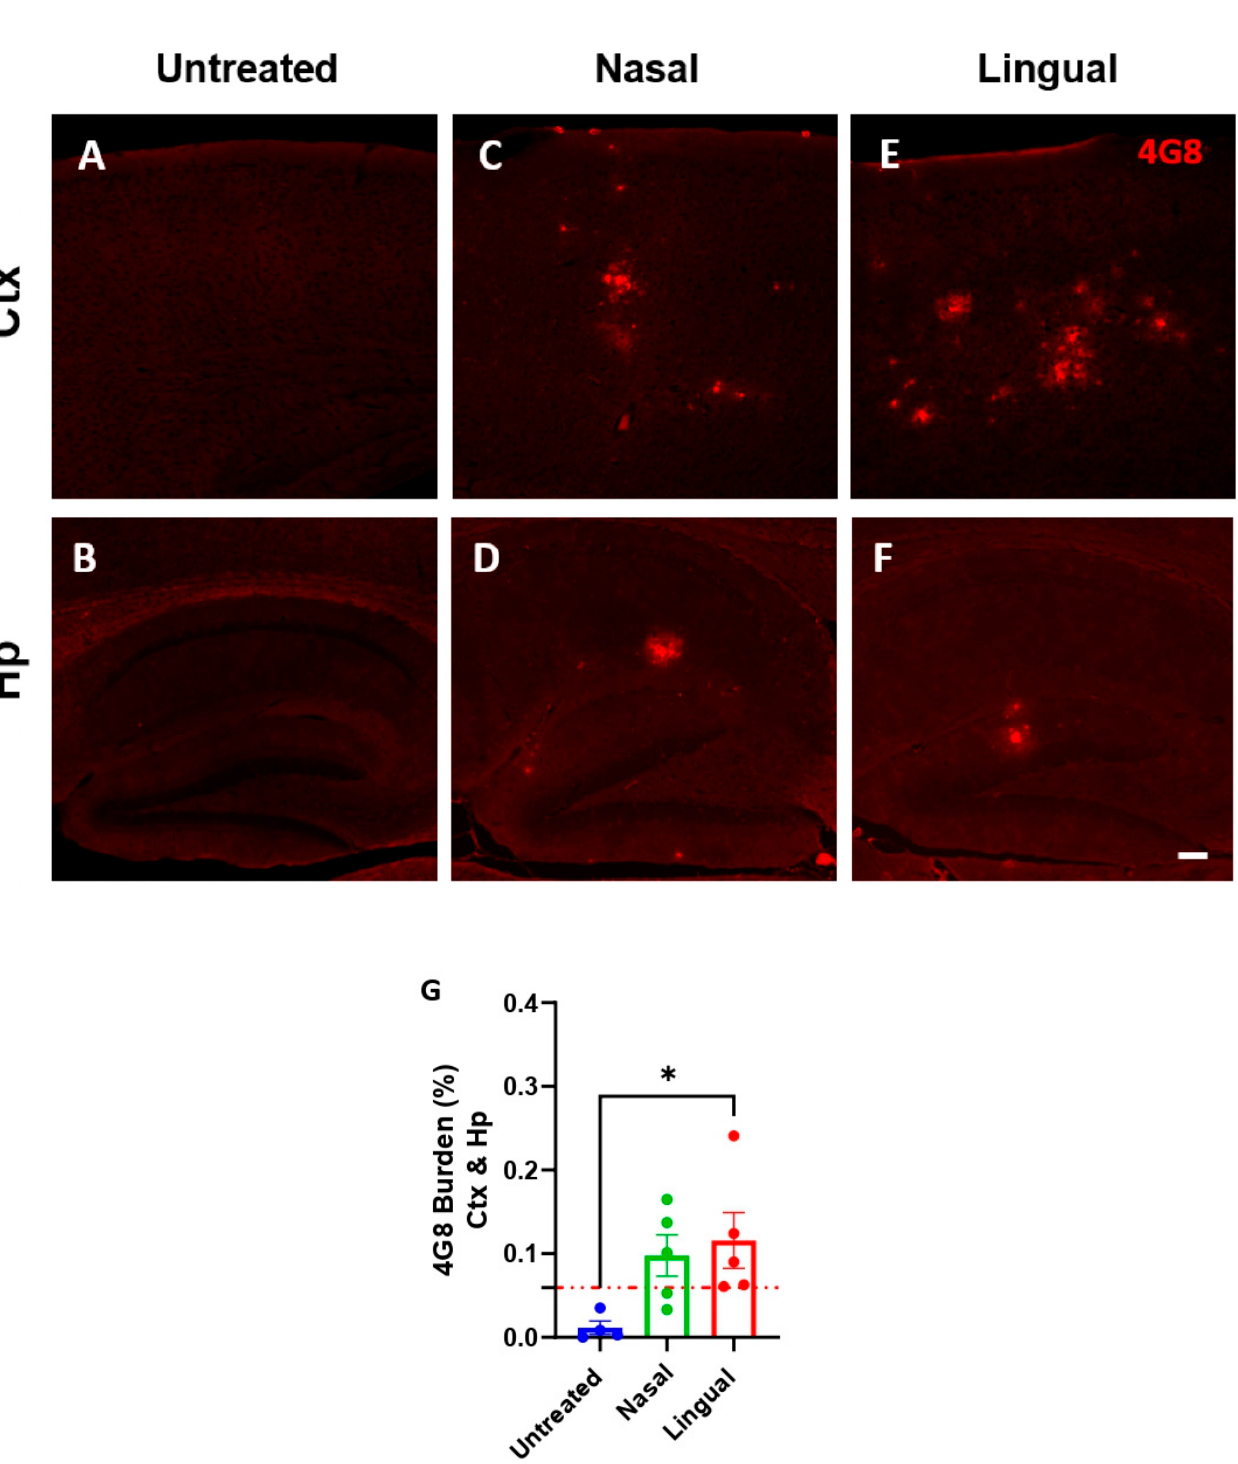
Figure 2. Acceleration of A β deposition in Tg2576 mice after exogenous administration of A β seeds by an intra-lingual injection. Representative pictures of 4G8 (total A β ) staining in cortex ( A – E ) and hippocampus ( B – F ) of untreated, extra-nasally or intra-lingually treated animals. 4G8 burden (%) quantification in cortex and hippocampus ( G ) of experimental animals. 4G8 burden is expressed as the percentage of the area stained by the 4G8 antibody versus the total area analyzed. Attack rate is represented as punctuated red lines in the graph. Values are expressed as mean ± SD. Statistical analyses were performed using One-way ANOVA and Tukey test (* p < 0.05). Scale bar represents 100 µm.